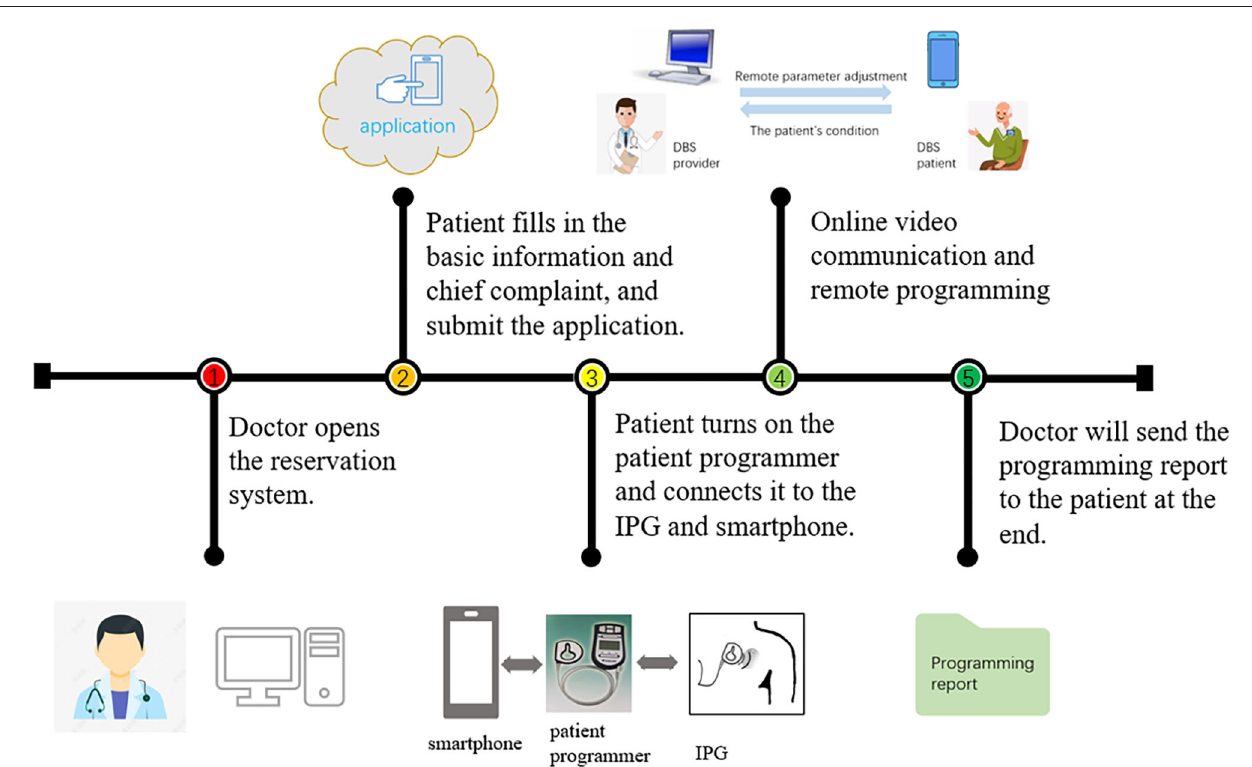
FIGURE 1 | Flow chart for remote programming. IPG, implantable pulse generator.